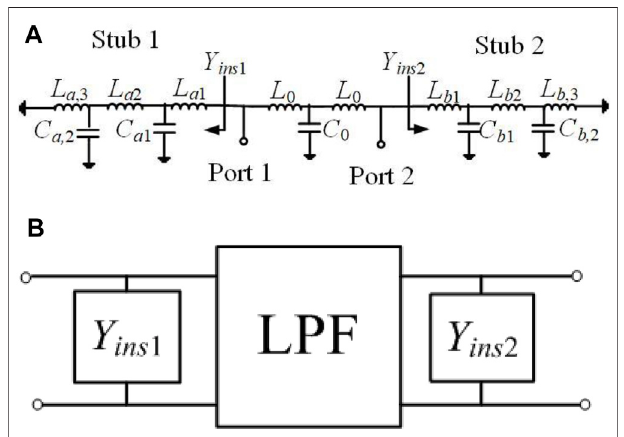
FIGURE 1 | Proposed BPF equivalent circuit and network (A) equivalent circuit (B) network model.